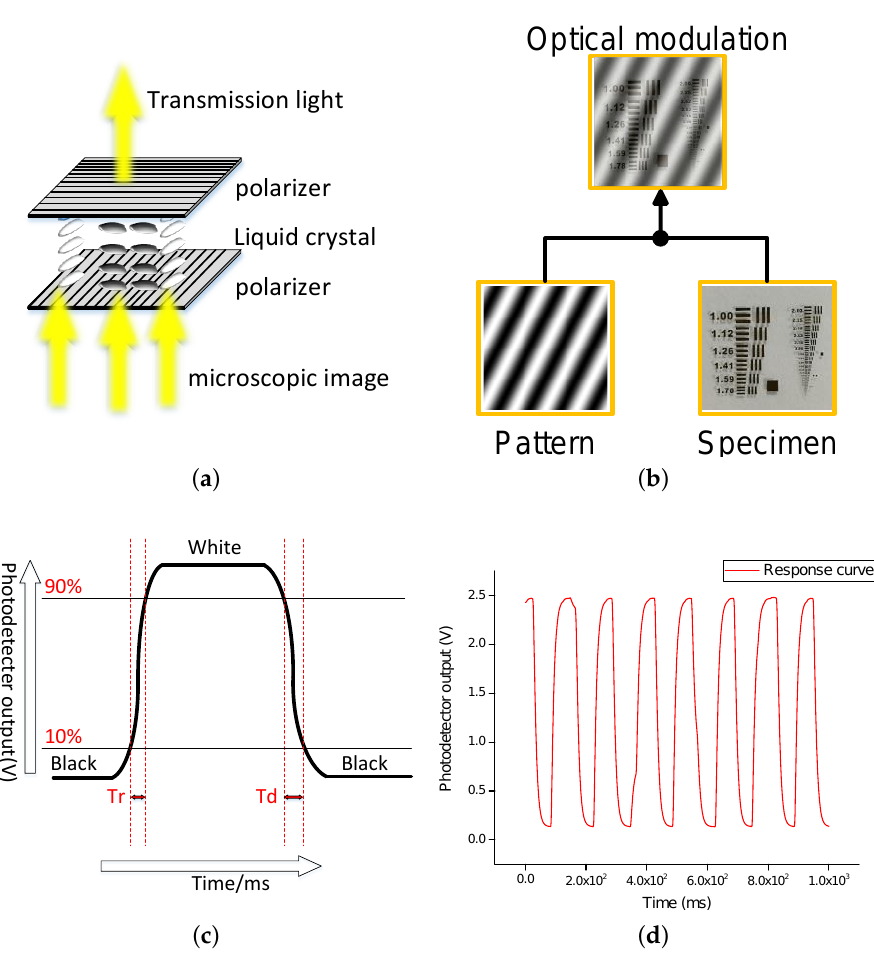
Figure 1. ( a , b ) liquid crystal modulation principle and modulation process of sinusoidal patterns as the microscopic image passes through liquid crystal spatial light modulator (LC-SLM). ( c , d ) the response time of the liquid crystal. The response time of LC-SLM (TSLM017-A) is Tr + Td The actual data of response time are measured by Data Acquisition (DAQ). The frame rate of LC-SLM is about 15 Hz. The sampling rate of DAQ is 1000